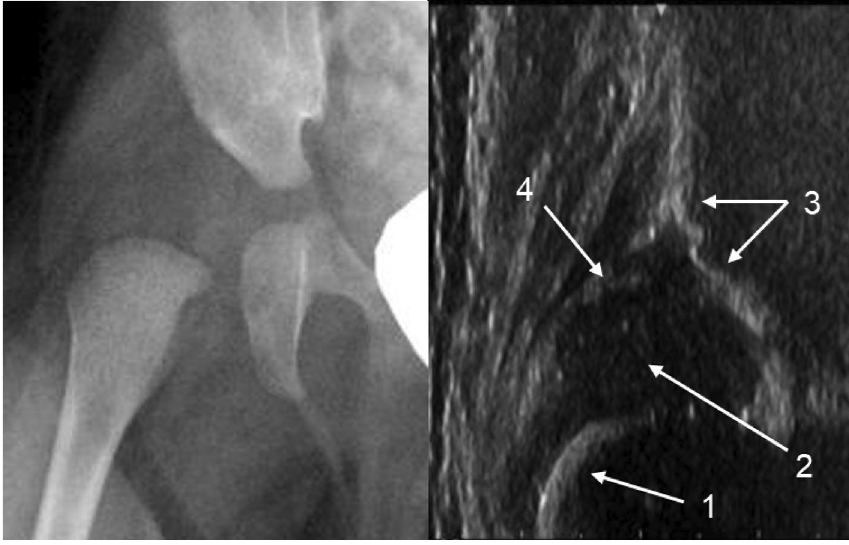
Figure 7. Hip anteroposterior radiography image (left) and hip ultrasonography image of the same hip (right). The patient was a 2-month-old girl. IHDI grade 2, Graf type D. Anatomical interpretation of the ultrasonography image: 1, bony part of the femoral neck. 2, cartilaginous femoral head. 3, bony part of acetabular roof. 4, acetabular labrum. IDHI International Hip Dysplasia Institute.